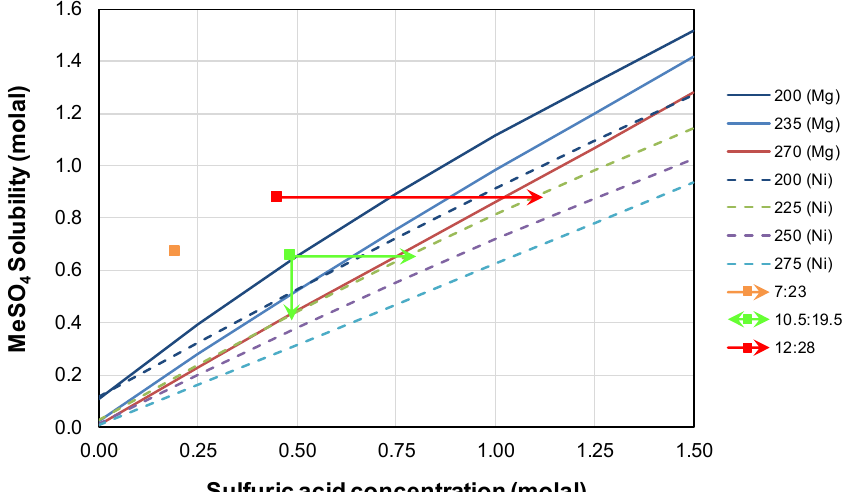
Figure 10. Modelled curves for the solubilities of MgSO 4 .H 2 O and NiSO 4 .H 2 O at selected temperatures ( ◦ C) as a function of sulfuric acid concentration [64,65]. Data points are for the final leach liquors obtained in the nickel concentrate to laterite tests in this study. The horizontal arrows selectively shown indicate the approximate sulfuric acid concentration required to keep the Mg and Ni in solution at 250 ◦ C. The vertical arrow (selectively shown) indicates the approximate combined solubility of the nickel and magnesium sulfates at this temperature.